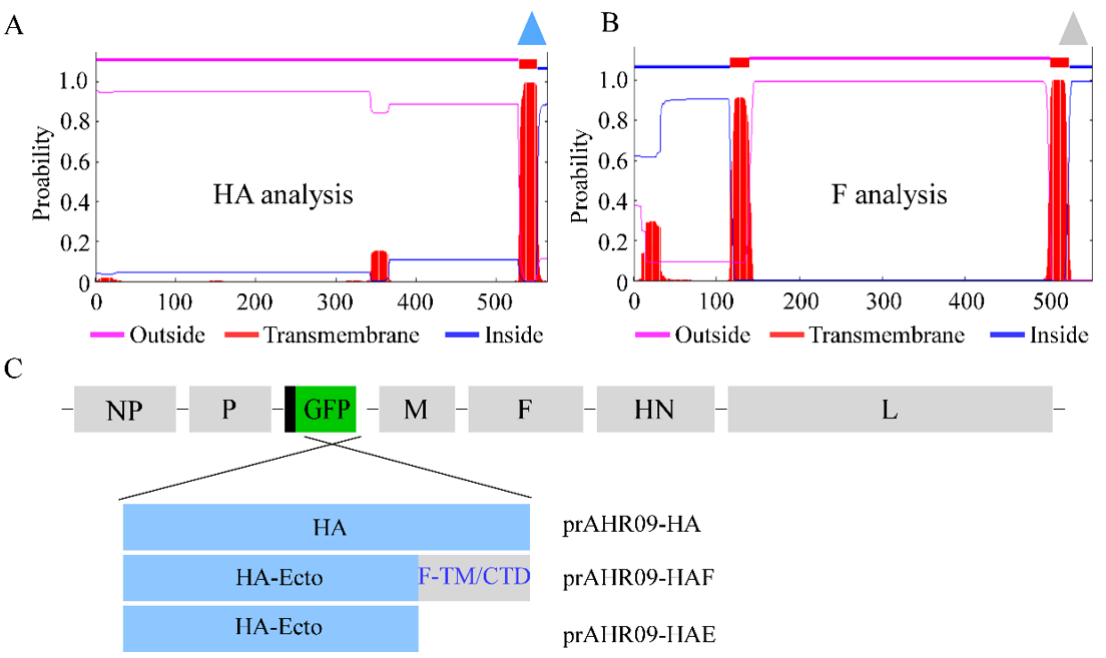
Figure 2. Schematics for the construction of three recombinant NDVs. ( A , B ) The transmembrane domain analysis of the